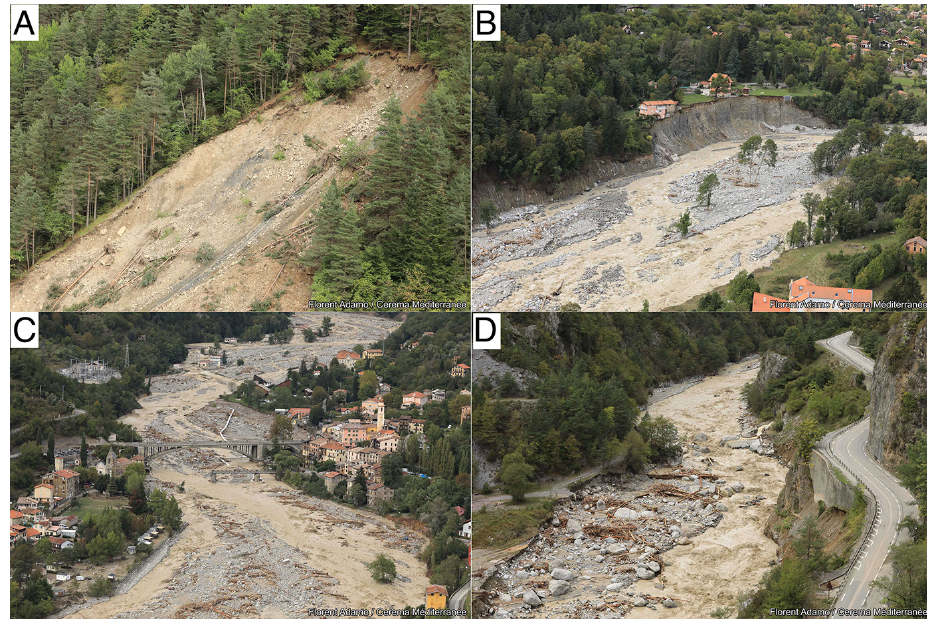
Figure B2. The consequences of Storm Alex in the Maritime Alps. (a) Landslide located upstream of the village of Saint-Martin-Vésubie on the right bank of the Boréon River. (b) Bank collapse next to the village of Saint-Martin-Vésubie. (c) Aerial view of the village of Roquebillière. (d) Partial bank collapse and deposited material next to the road in the commune of Roquebillière. Photo credits: Flo- rent